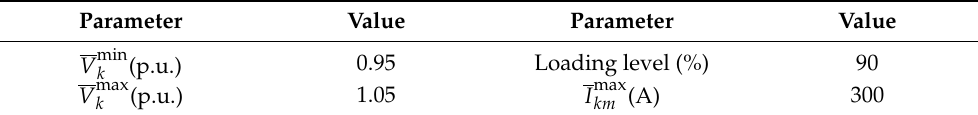
Table 10. General data and input parameters, Case 5b.